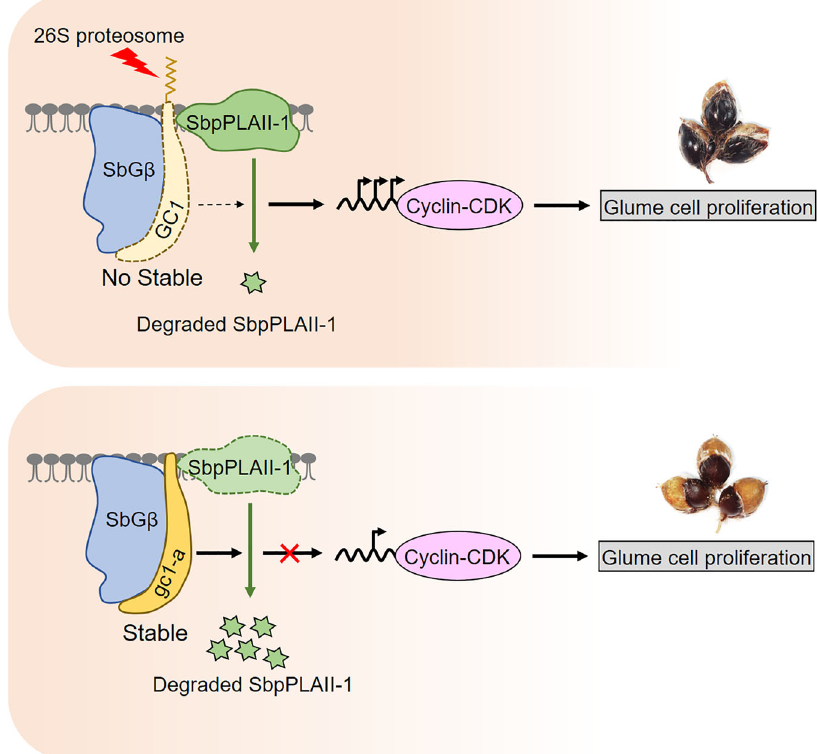
Fig. 7 A proposed working model for GC1 regulates SbpPLAII-1 degradation and controls glume coverage. G protein β subunit and G protein γ subunit GC1 could form a dimer to conduct a G βγ -mediated signaling. SbpPLAII-1 functions as a positive regulator in glume cell proliferation by promoting the transcripts of Cyclin-CDK related genes. The G protein γ subunit can interact and promote the degradation of SbpPLAII-1. In wild type, the long tail of GC1 could increase the 26S proteasome-dependent degradation, resulting in an unstable protein level. This subsequently leads to a normal phospholipase SbpPLAII-1 level and results in a fi nal high glume coverage phenotype in sorghum. However, the truncated gc1-a protein (short tail) is more stable than GC1 (long tail) due to the absence of C-terminus, and then enhances the degradation of SbpPLAII-1. It leads to a signi fi cantly inhibited SbpPLAII-1 signal involved in glume cell proliferation and therefore causes low glume coverage in